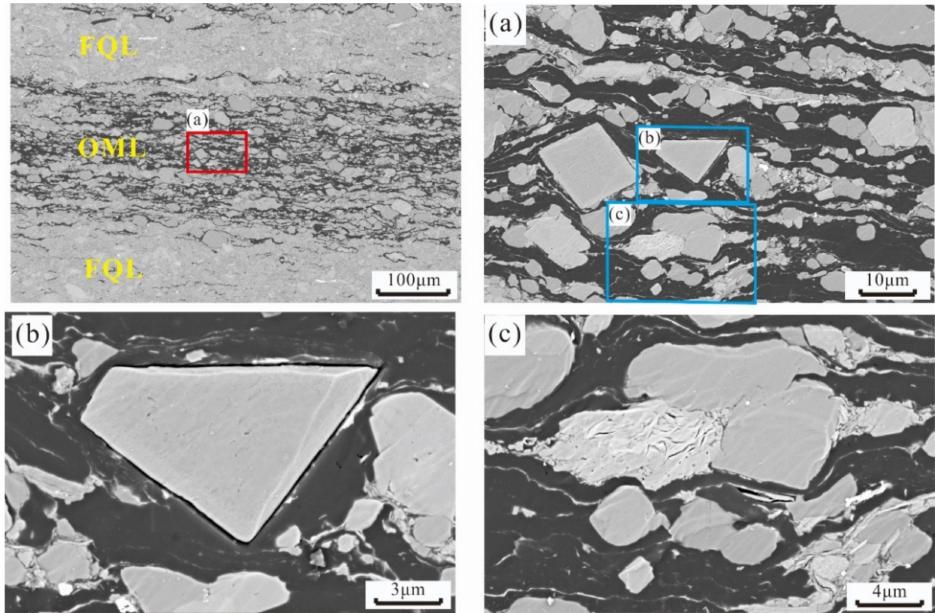
Figure 9. SEM images of OML from Well G108-8 at 2956 m. ( a ) Magnification of OML; ( b ) organic matter pores; ( c ) intercrystalline pores of clay minerals in OML. FQL: feldspar-quartz laminae; OML: organic matter